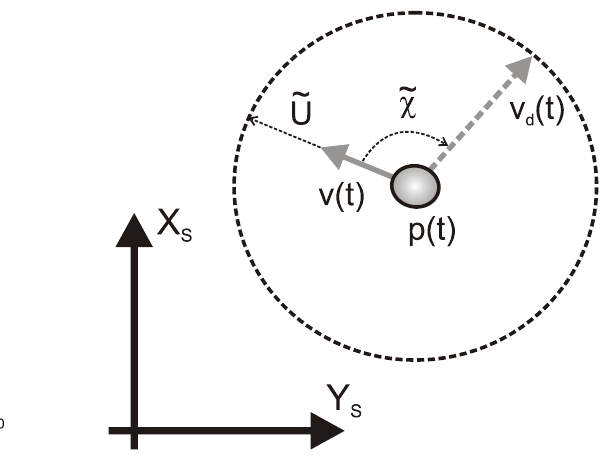
Figure 9: Top: Complete surge speed step response. Bottom: Actual and approximated displace- ment region responses.